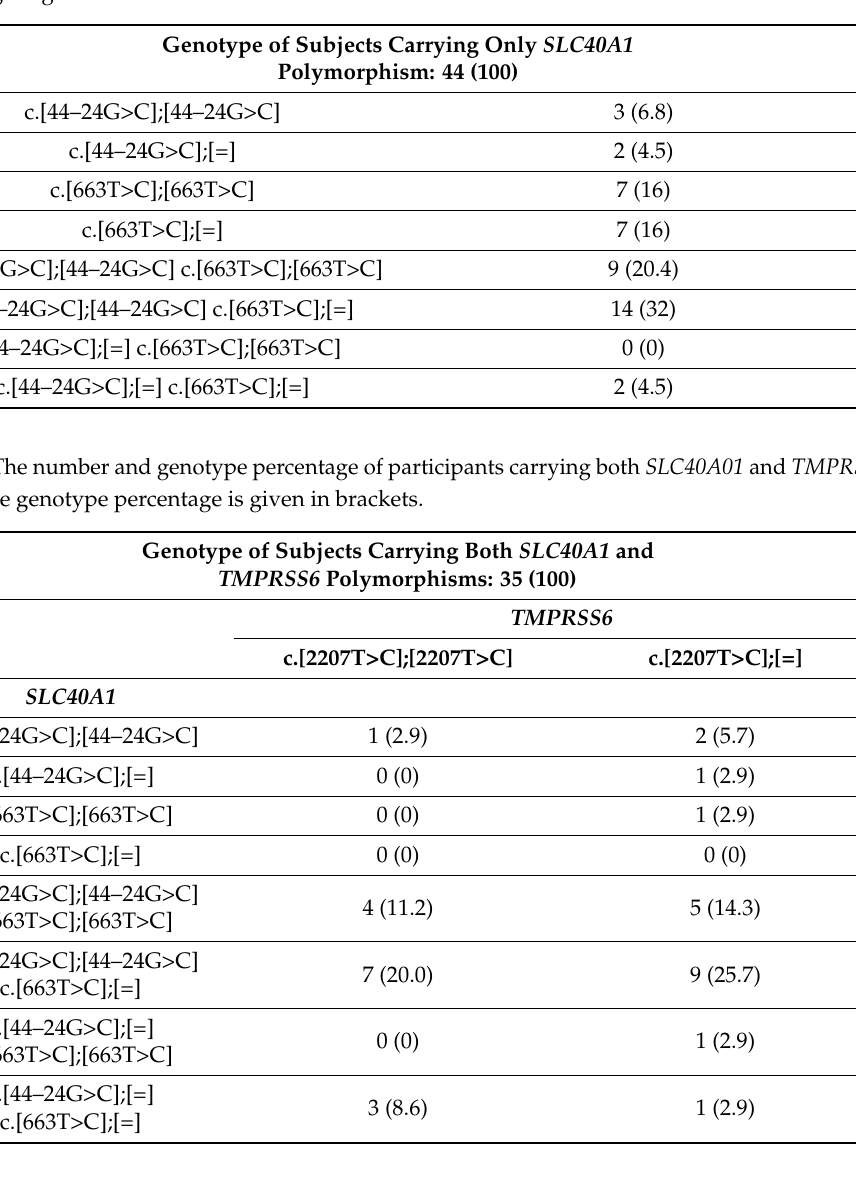
Table 2. The number and genotype percentage of participants carrying SLC40A01 only. The genotype percentage is given in brackets.